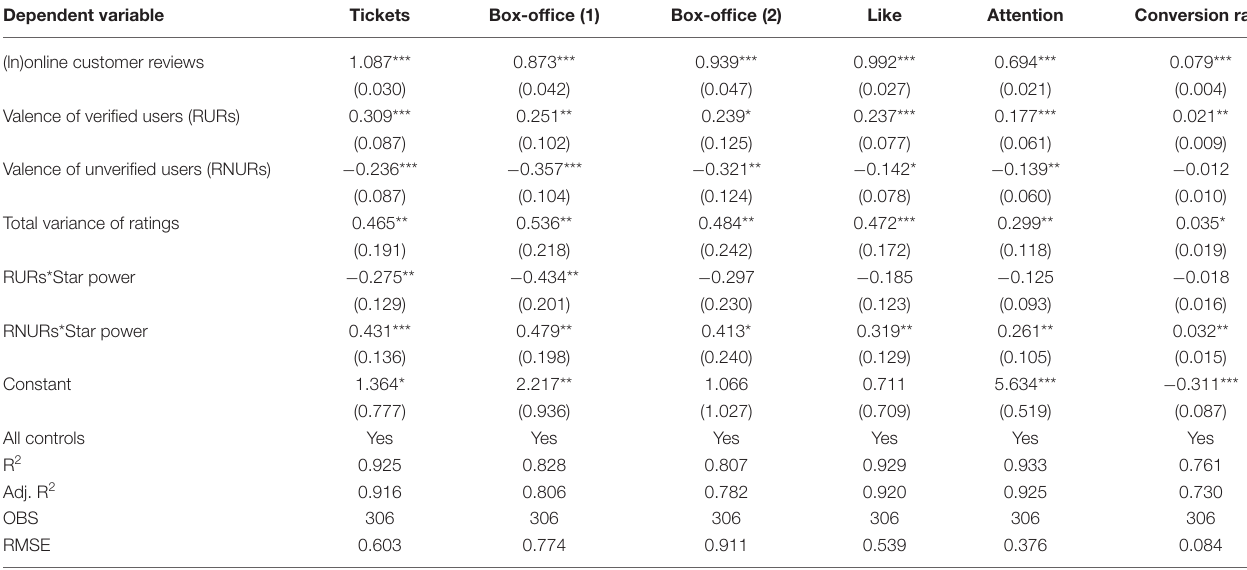
TABLE 4 | Robustness test for the different dependent variable (Model